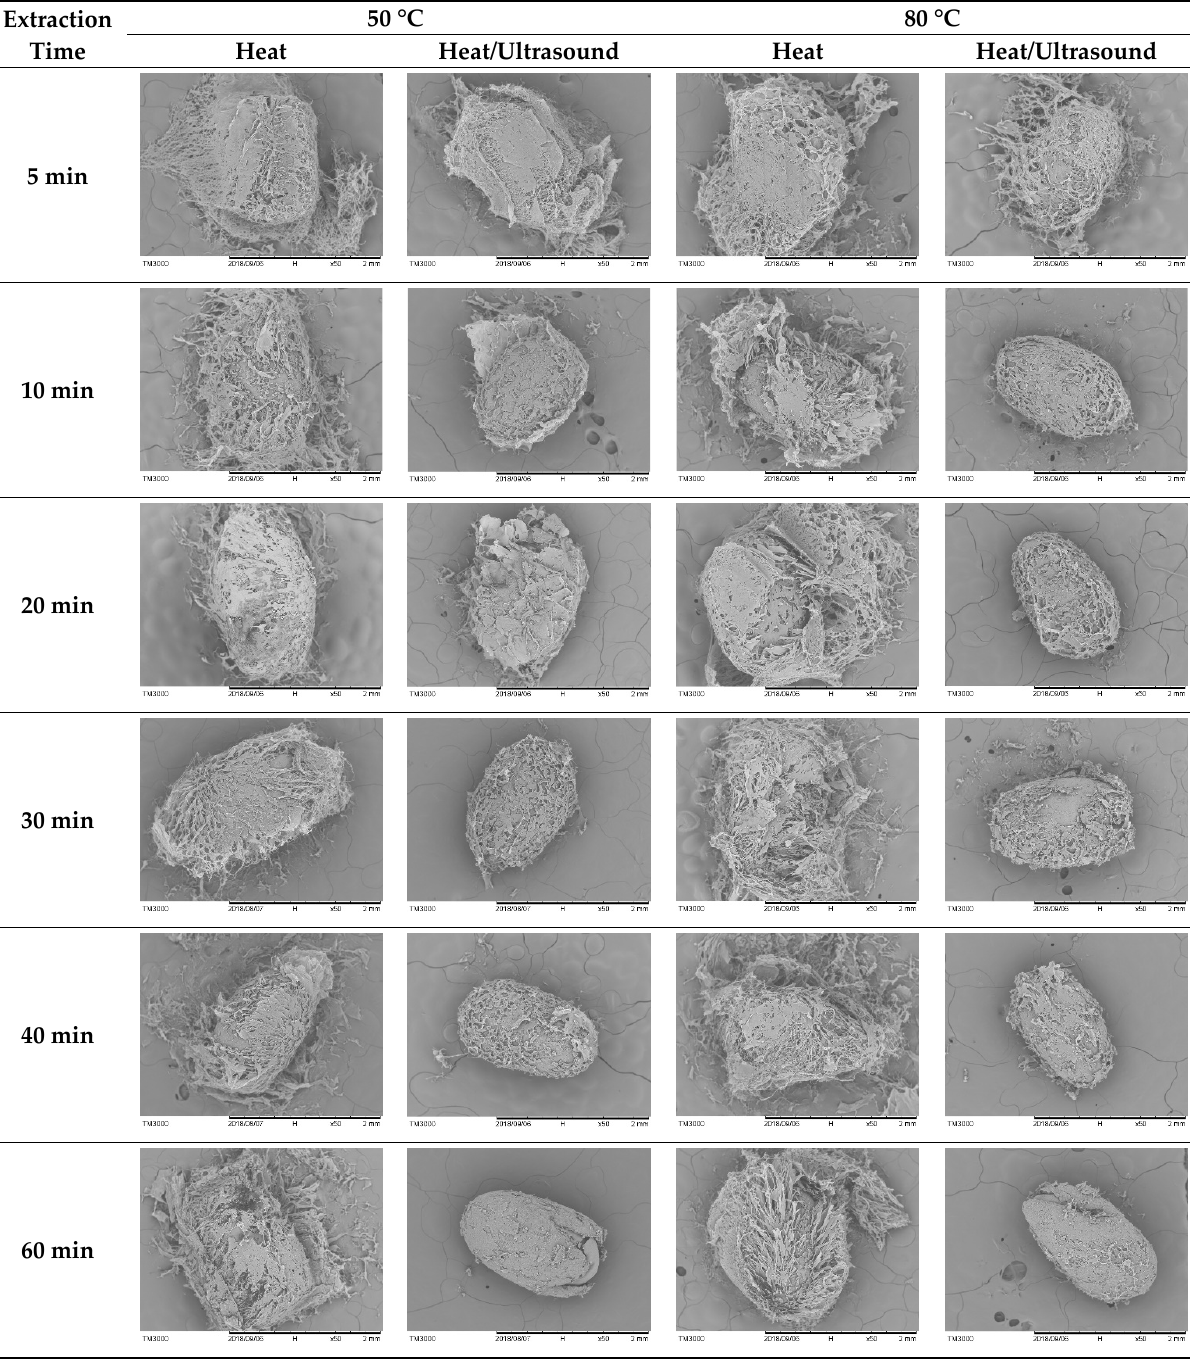
Figure 2. Scanning electron microscopy (SEM) images (×50) of chia seeds extracted at 50 °C and 80 °C under different conditions.